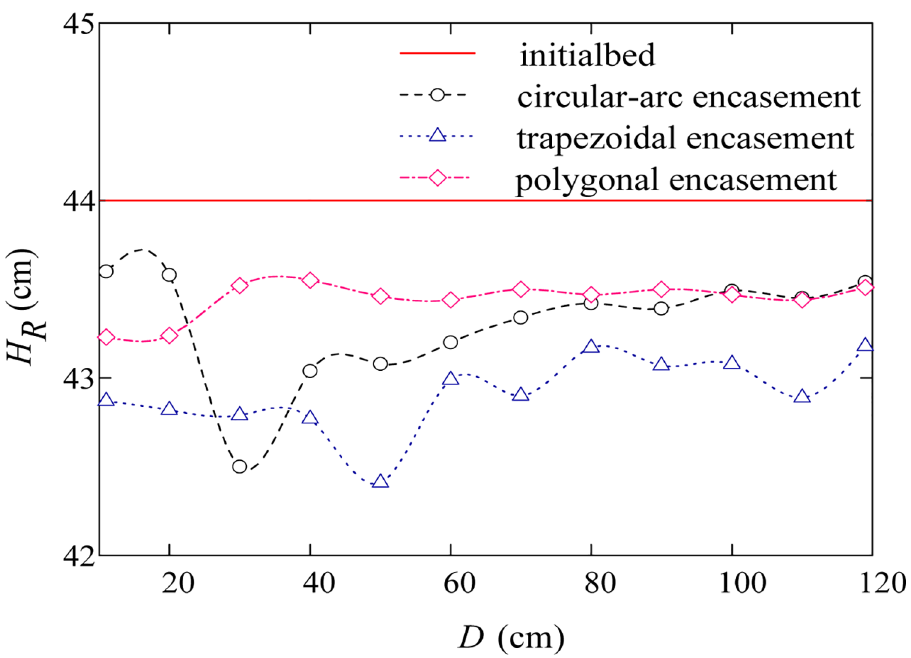
Fig 8. Transversal scour profile of CS6 for a 3-year flood